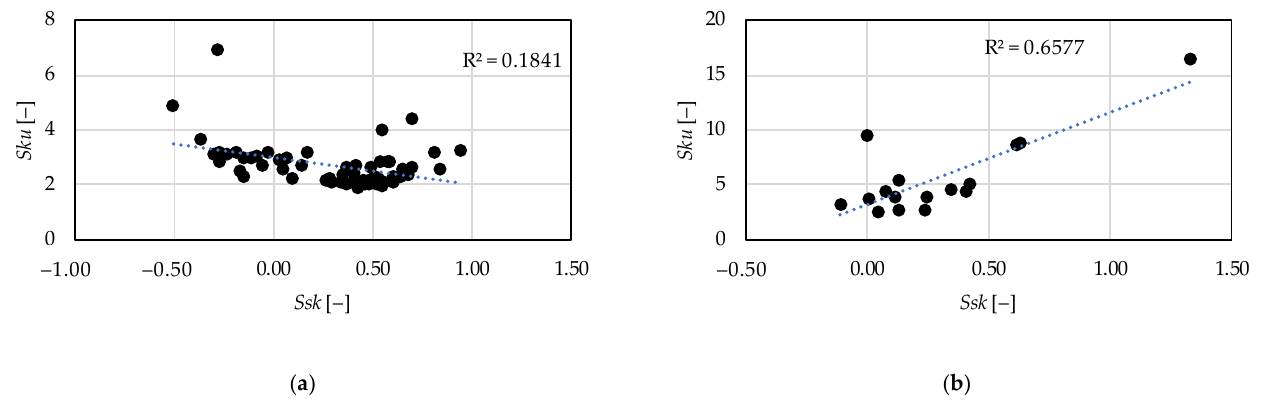
Figure 15. Connection between the skewness— Ssk and the kurtosis— Sku parameters ( a ) hard turning; ( b ) grinding.